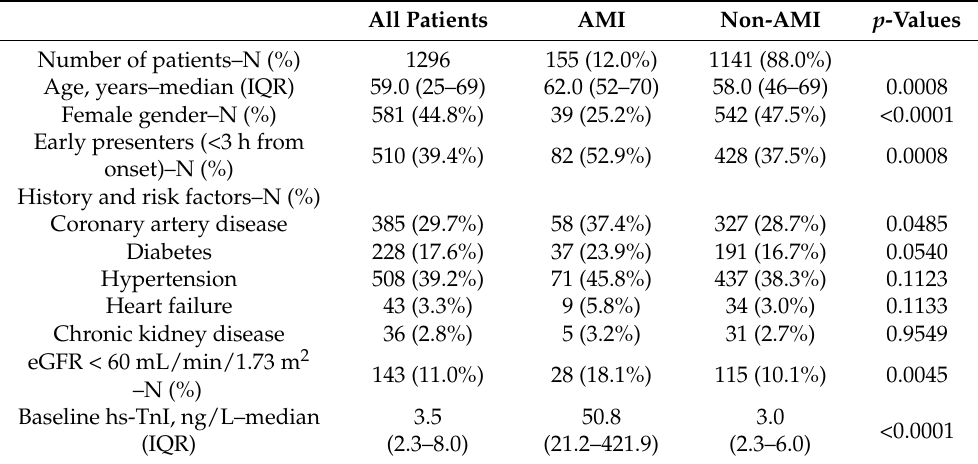
Table 1. Baseline characteristics and Access hs-TnI levels of 1296 patients with ischemic